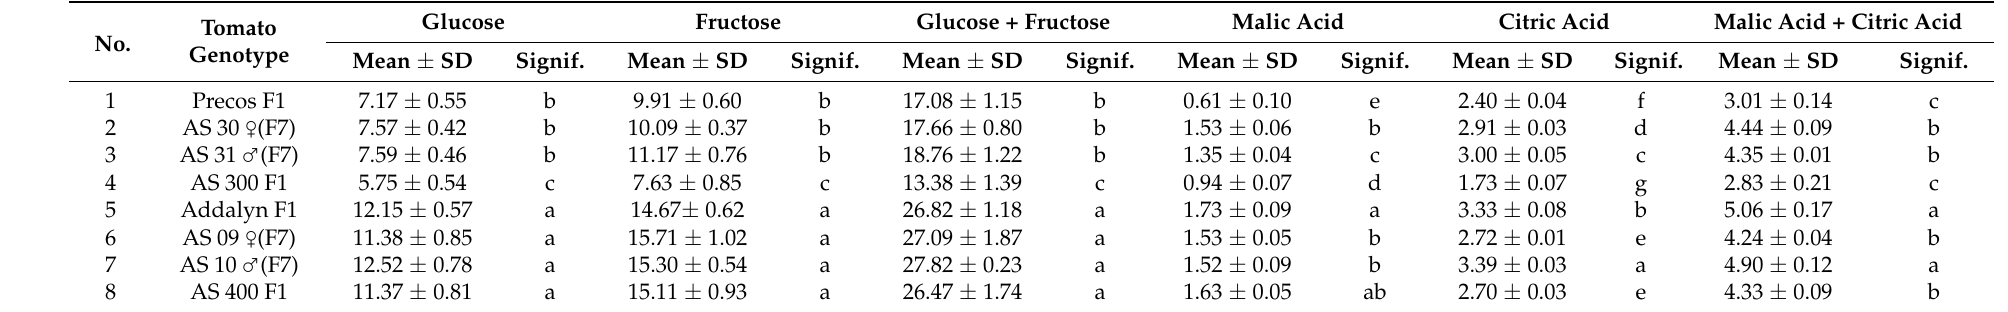
Table 1. Amount of carbohydrates and organic acids for tomato samples, expressed in mg/g fresh weigh.